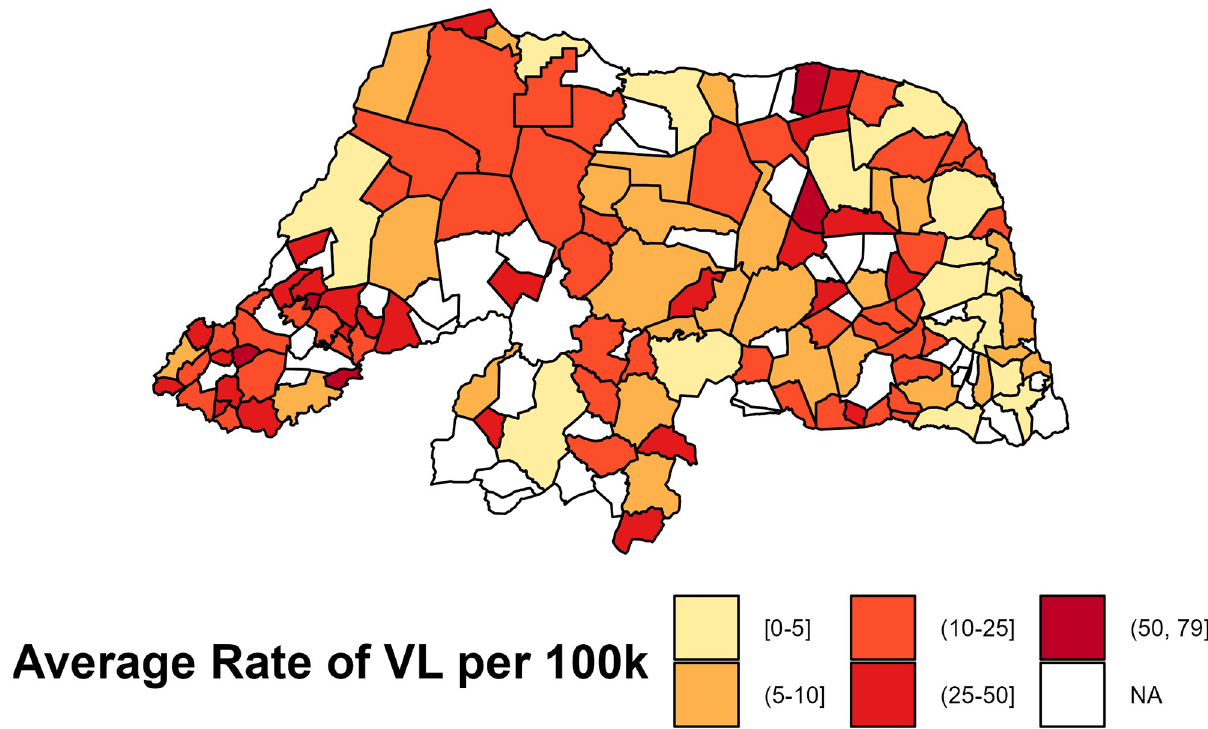
Fig 3. Distribution of average human visceral leishmaniasis rates per 100,000 in Rio Grande do Norte between 2007 and 2020. This figure was created using the geobr package in R [25].